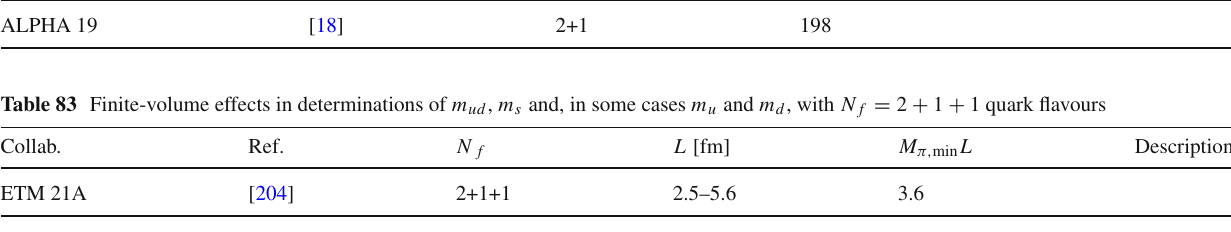
Table 82 Chiral extrapolation/minimum pion mass in determinations of m ud , m s and, in some cases m u and m d , with N f = 2 + 1 quark flavours Collab. Ref.